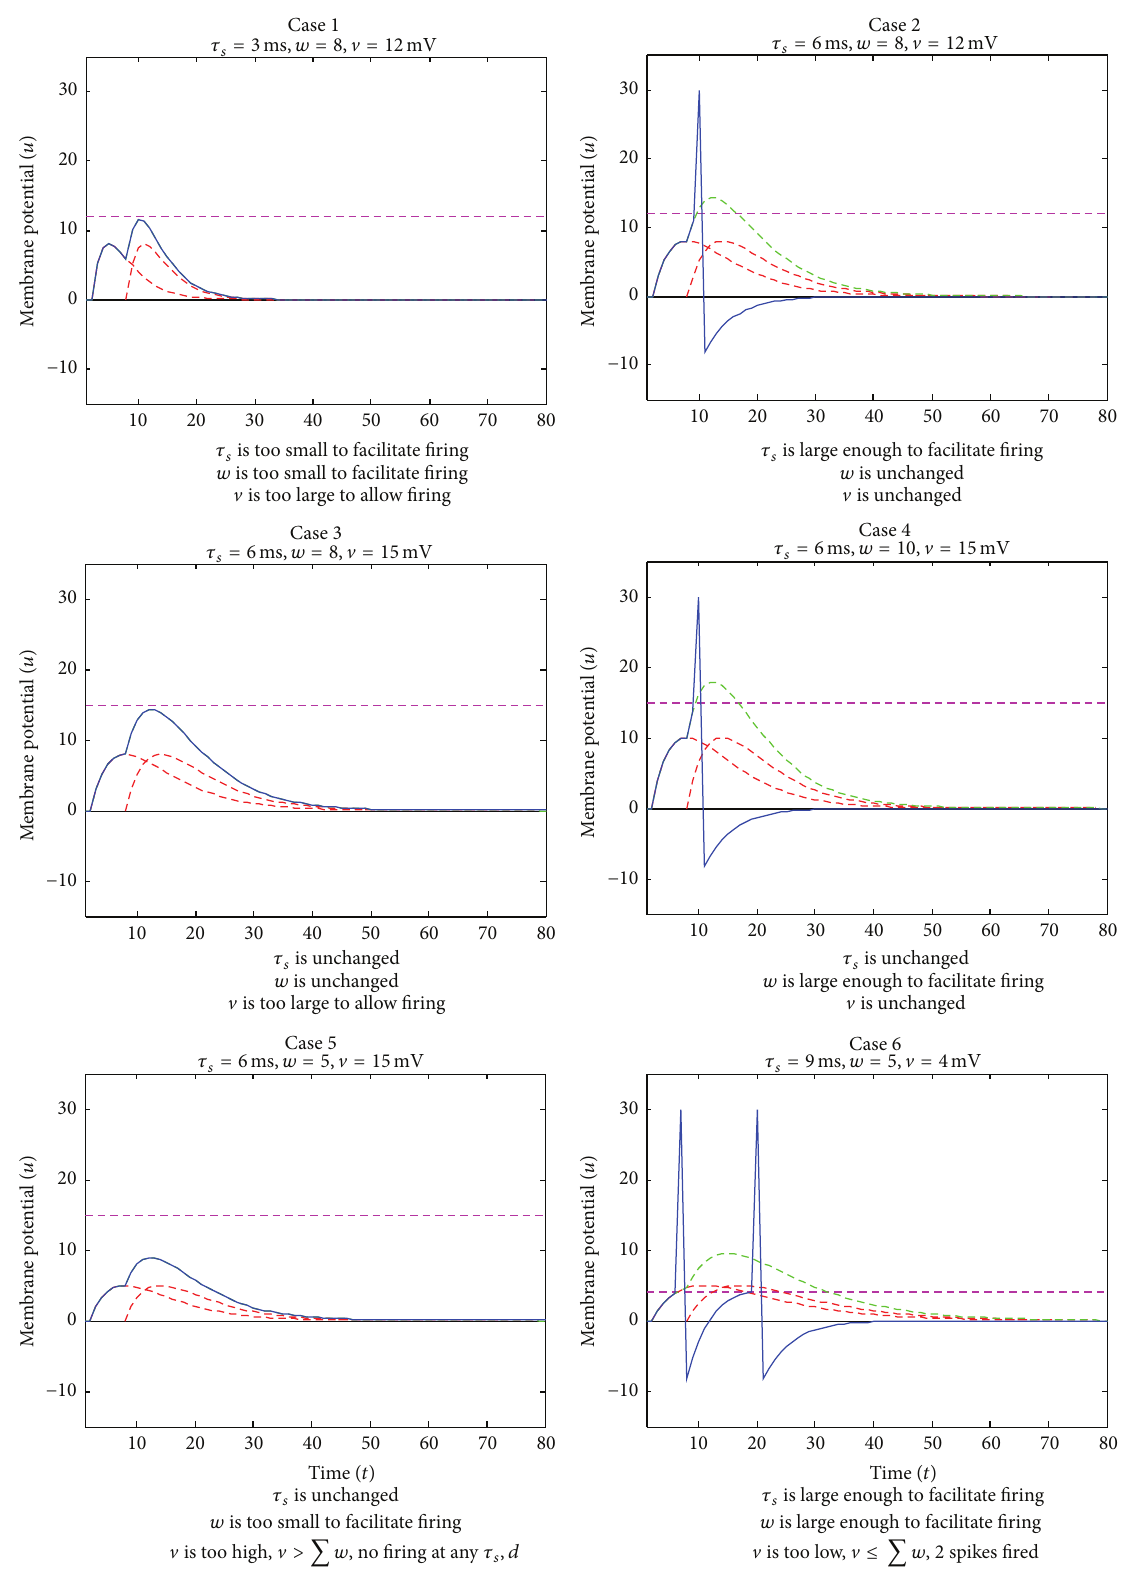
Figure 2: Several cases of coincidence detection between two presynaptic